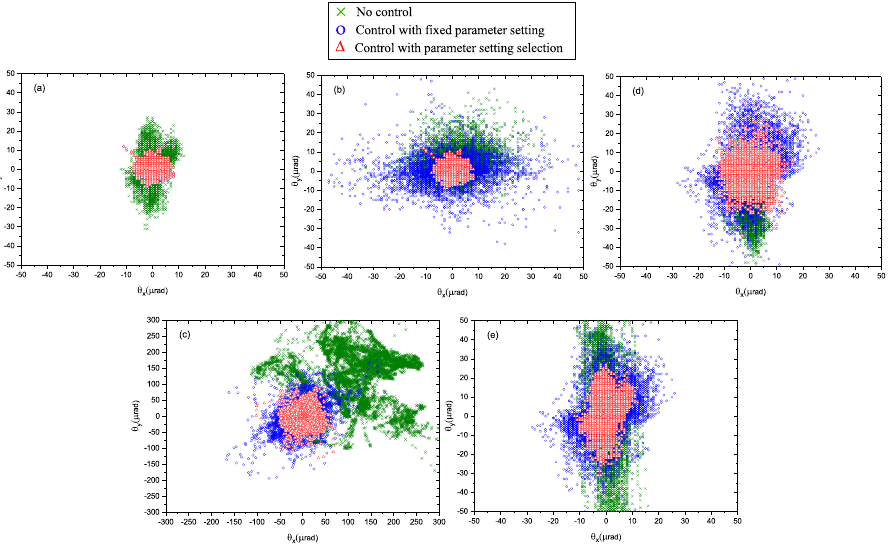
Figure 8. 2D beam pointing distributions in the presence of five disturbance types. ( a ) Inherent drift. ( b ) Air disturbance. ( c ) Transmission medium variation. ( d ) Mechanical vibration. ( e ) Elastic deformation. The three colors correspond to different control